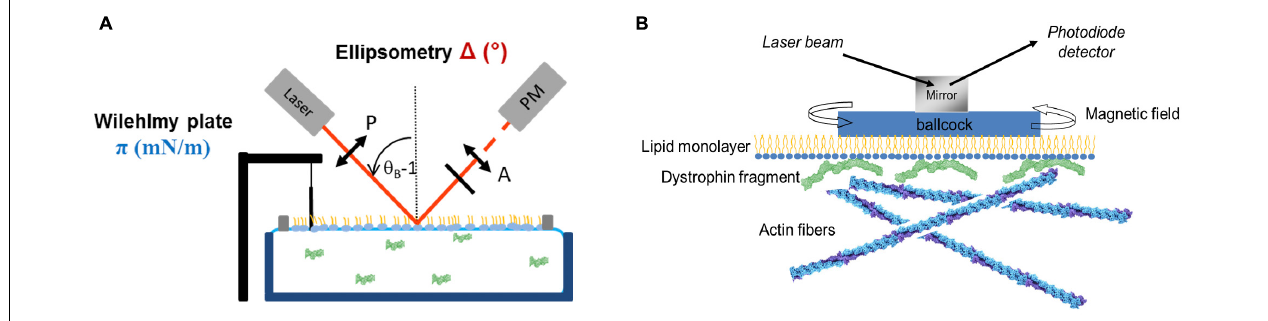
FIGURE 2 | (A) Illustration of Langmuir trough associated with Wilhelmy plate and the ellipsometry setup. Adapted from Vié et al. (2018). (B) Interfacial rheological setup used to measure lipid monolayer rheological properties when interacting with dystrophin fragment and actin filaments. Adapted from Sarkis (2012).